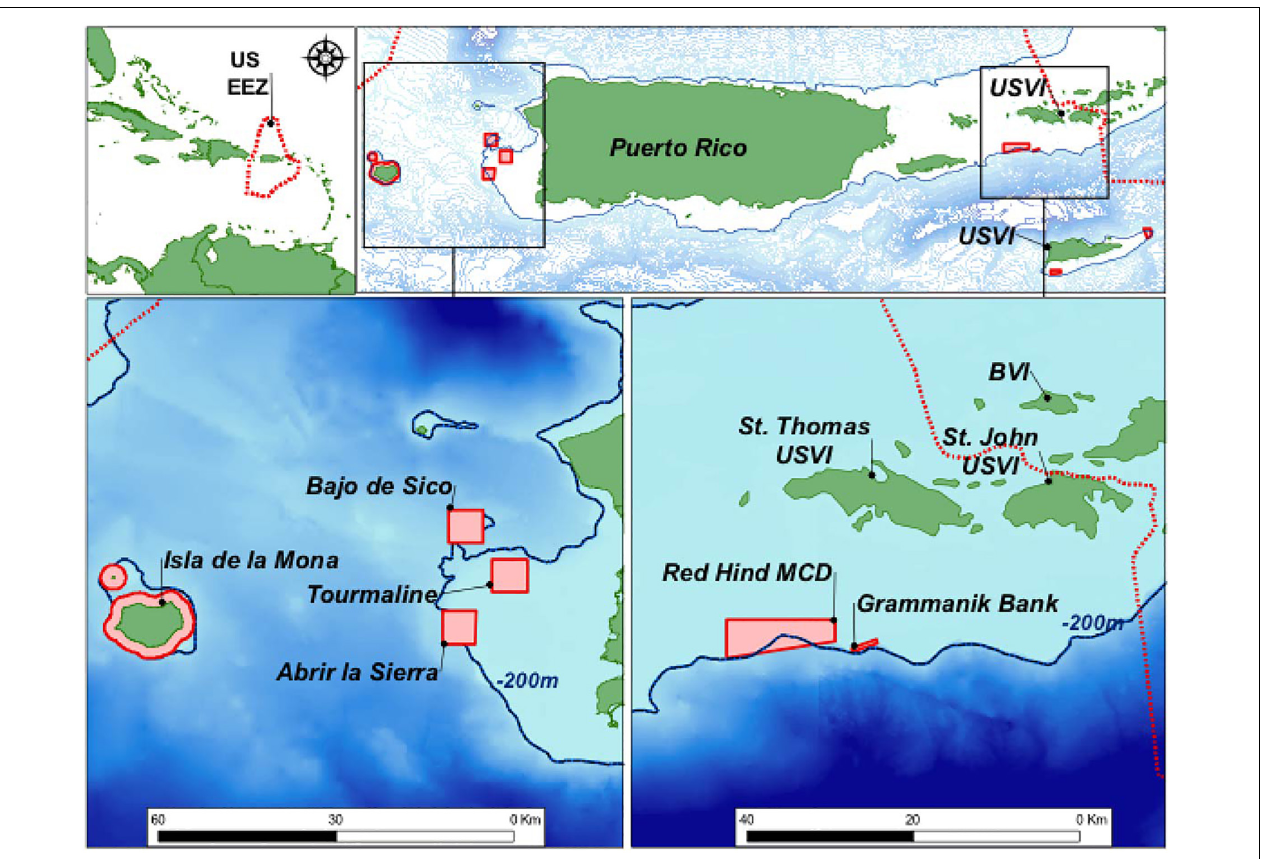
FIGURE 6 | Fish spawning aggregation (FSA) sites on the western shelf of Puerto-Rico, including Abrir La Sierra (ALS) and on the southern shelf of St. Thomas in the U.S. Virgin Islands, namely the Red Hind Marine Conservation District (MCD) where the Red Hind Bank (RHB) is located and the Grammanik Bank